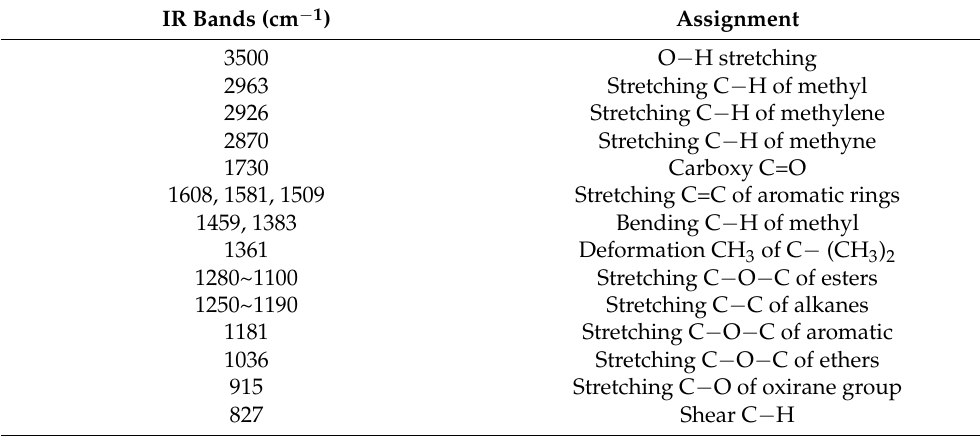
Table 2. Spectral bands of FTIR characteristic peaks corresponding to main